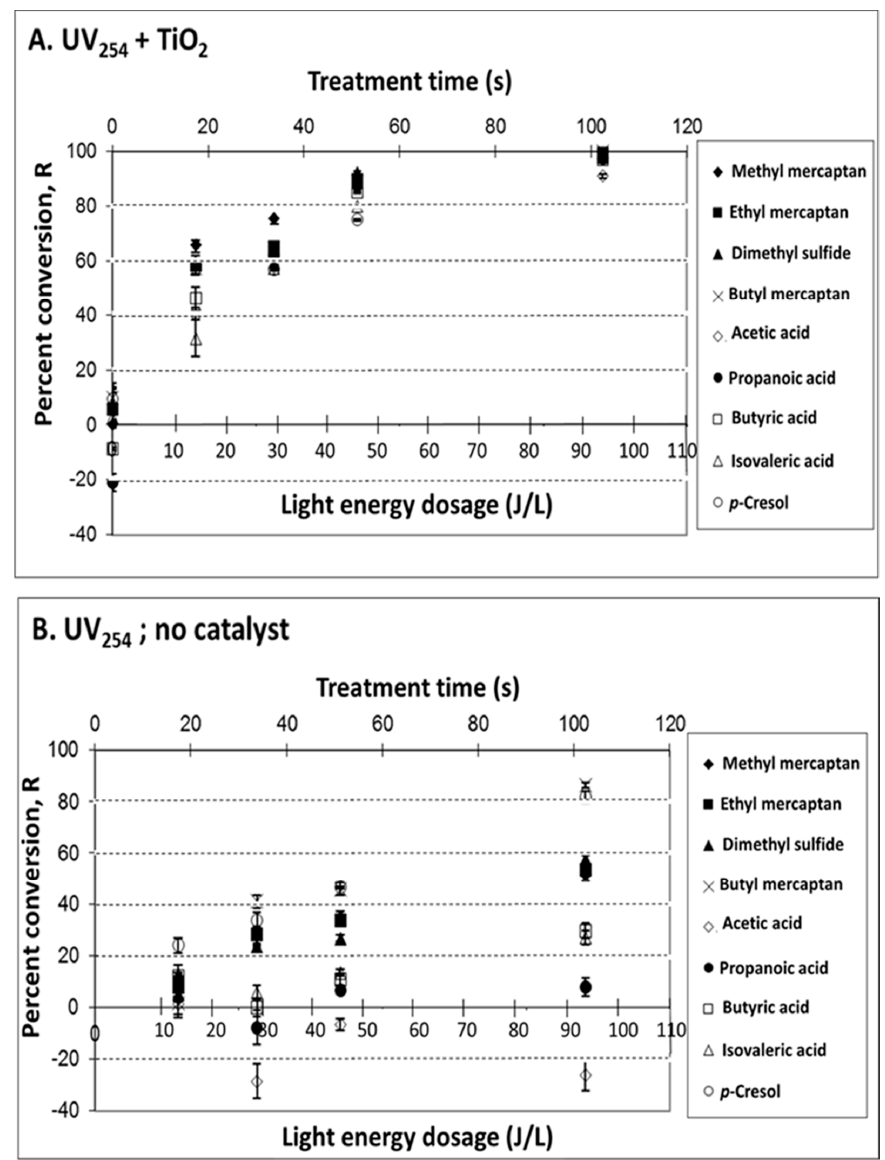
Figure 2. Treatment of target odorous VOCs in a synthetic mixture with UV lights of 254 nm principal output (i.e., no deep UV 185 nm output). Effects of measured light energy dosage (at different treatment times) on VOC percent conversion, R: ( A ) UV 254 + TiO 2 (treatment mainly via photocatalysis); ( B ) UV 254 , no catalyst (treatment mainly via photolysis). Experimental conditions: UV intensity at 254 nm, 312 nm and 365 nm was 1.5, 0.230, and 0.084 mW cm − 2 , respectively; 25 mg TiO 2 ; T = 25 °C; dry air; sampling conditions: 5 min SPME sampling time with CAR/PDMS 85 μ m. The light energy dosage is based on the output at 254 nm only.